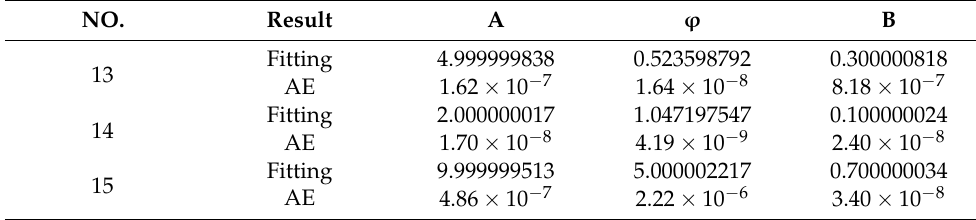
Table 15. Fitting value and absolute error of MQ-LS.